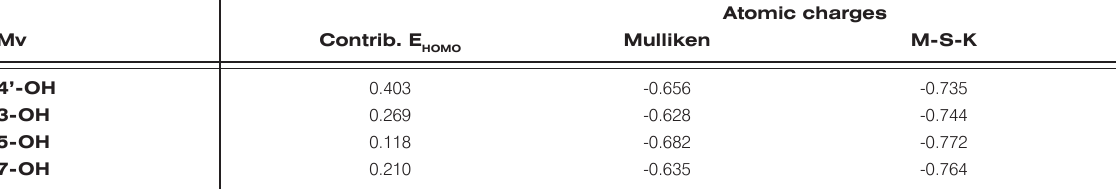
Table 7. Contributions to the E and atomic charges of the O atoms of the malvidin hydroxyl groups (HF/6-31+G(2d,p) HOMO